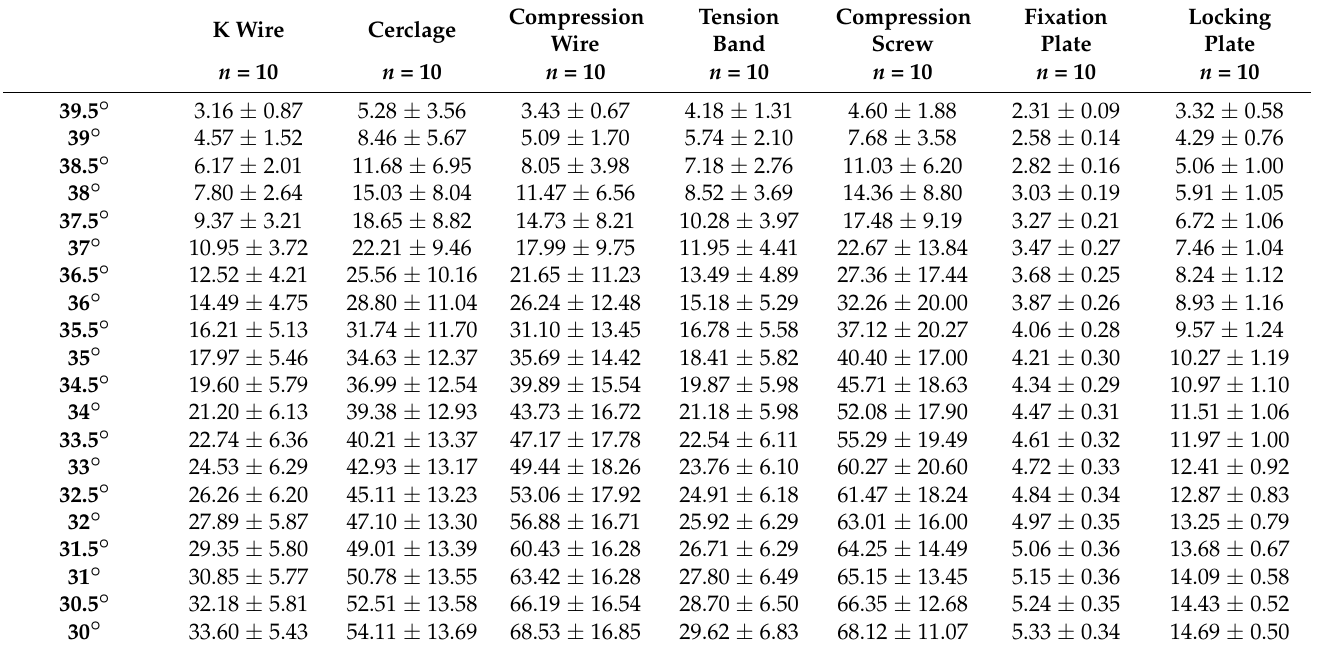
Table 1. Extension of PIP joint arthrodesis with different techniques.